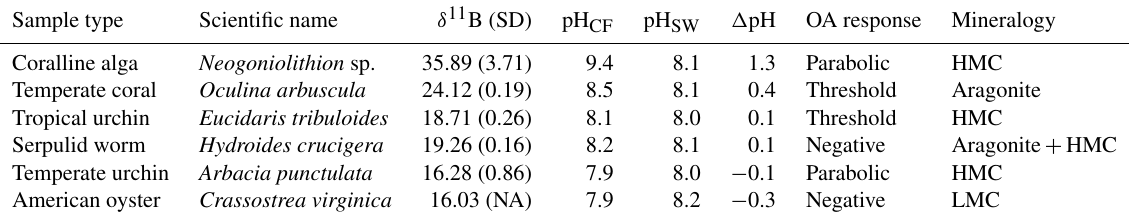
Table 4. Summary of the average and standard deviation (SD) of δ 11 B for each species (‰), calculated pH of calcifying fluid (pH CF ) , pH of seawater (pH SW ) during the experimental conditions, difference between pH CF and pH SW ( (cid:49) pH), calcification response to ocean acidification experiments (OA response; Ries et al., 2009), and shell/skeletal mineralogy (HMC: high-Mg calcite; LMC: low-Mg calcite; Ries et al., 2009). In most cases three biological replicates of each species were analyzed. NA: not available because only one biological replicate has been analyzed.